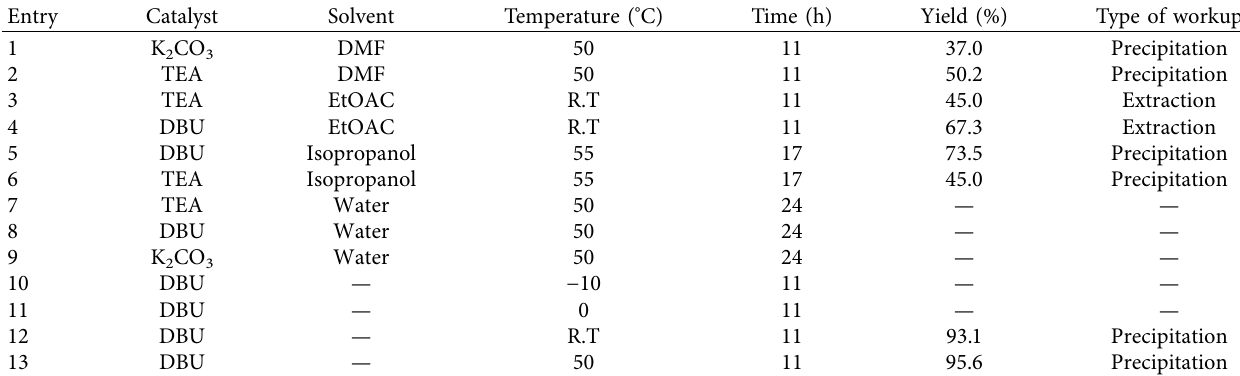
Table 3: Optimization of the N-acylation reaction conditions in view of solvents, bases, and temperature. Entry